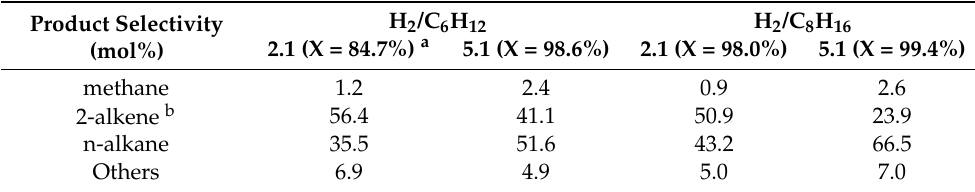
Table 3. Reactions of C 6 H 12 and C 8 H 16 in H 2 atmosphere (T = 533 K, p = 0.8 MPa).